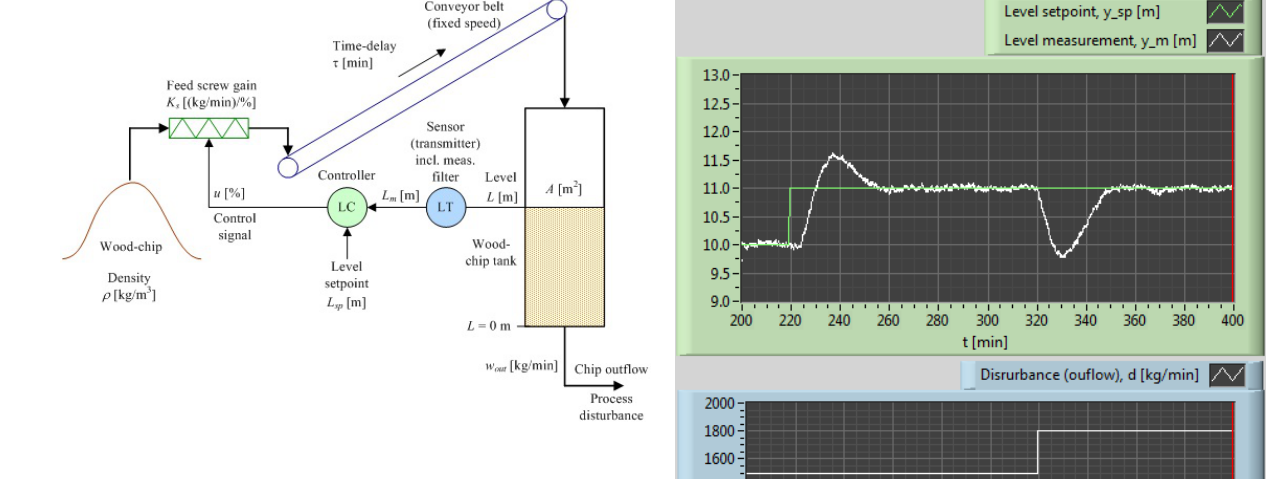
Figure 11: Level control system for a wood-chip tank.